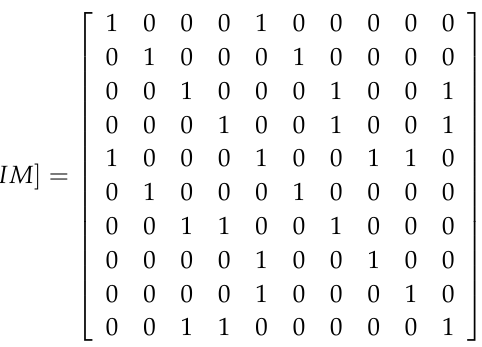
Figure 4. A graph consisting of 10 edges and 8 vertices with non-consecutive numbering.